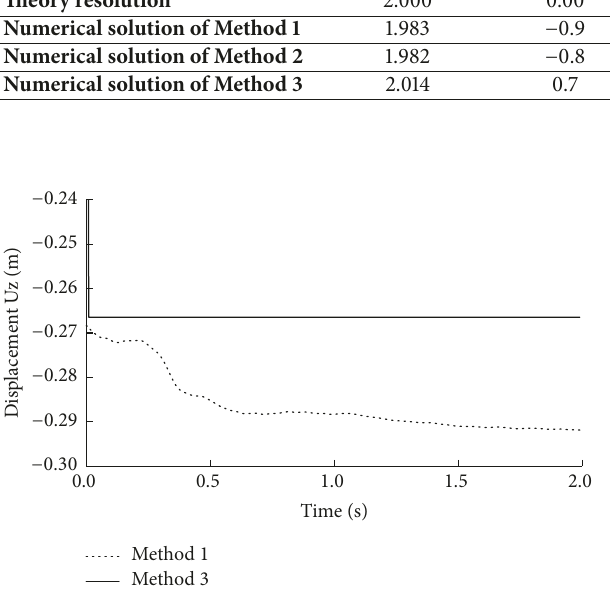
Figure 11: Displacements of Point O under zero dynamic load.